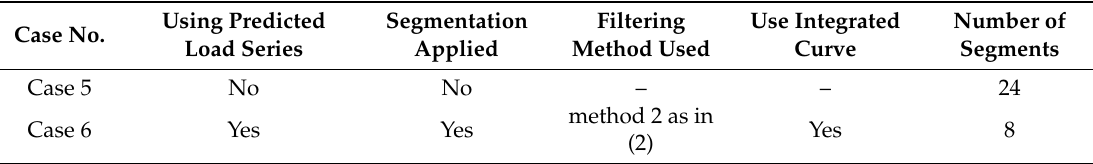
Table 3. Experimental parameters for cases 5 and 6.